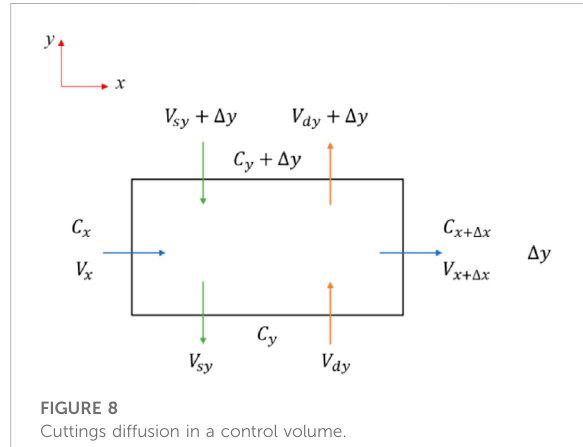
FIGURE 7 Particle rolling.